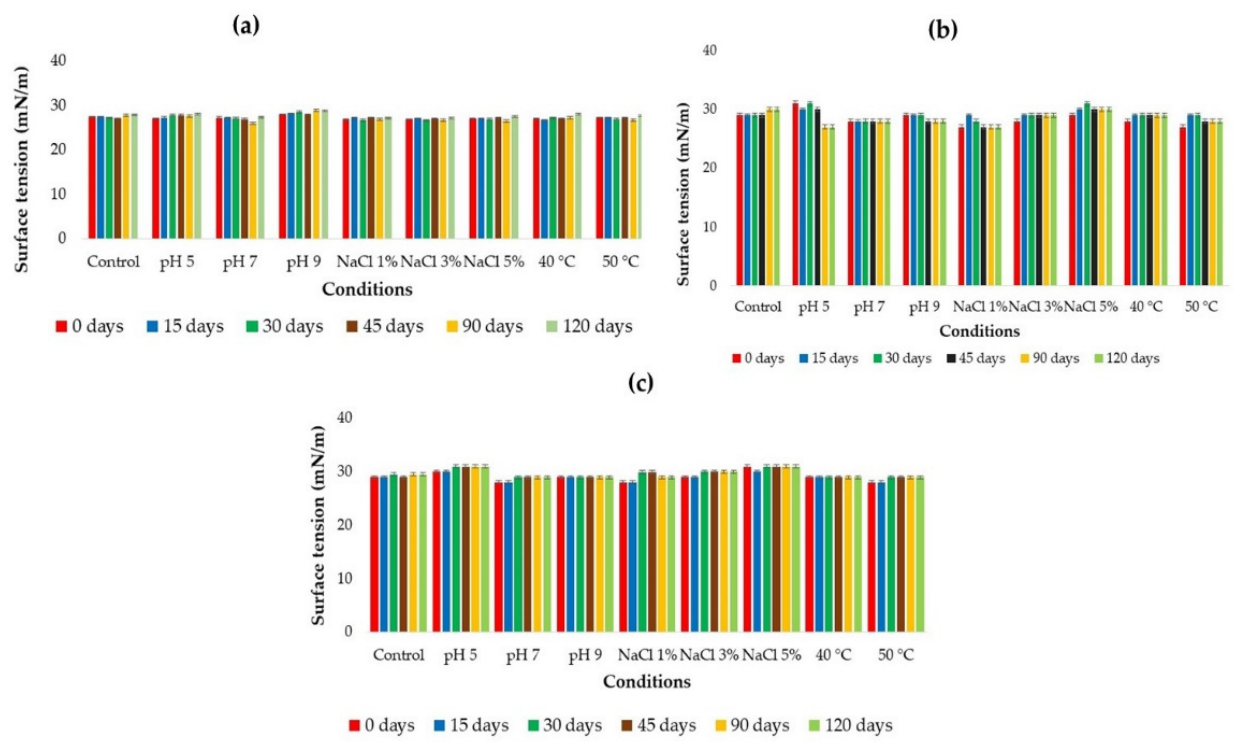
Figure 6. Surface tension results of the biosurfactant produced by Candida sphaerica submitted to different preservation treatments, ( a ) 0.2% potassium sorbate, ( b ) fluent steam + 0.2% potassium sorbate, ( c ) fractionated tyndallization, and stored under different conditions over a period of 120 days.